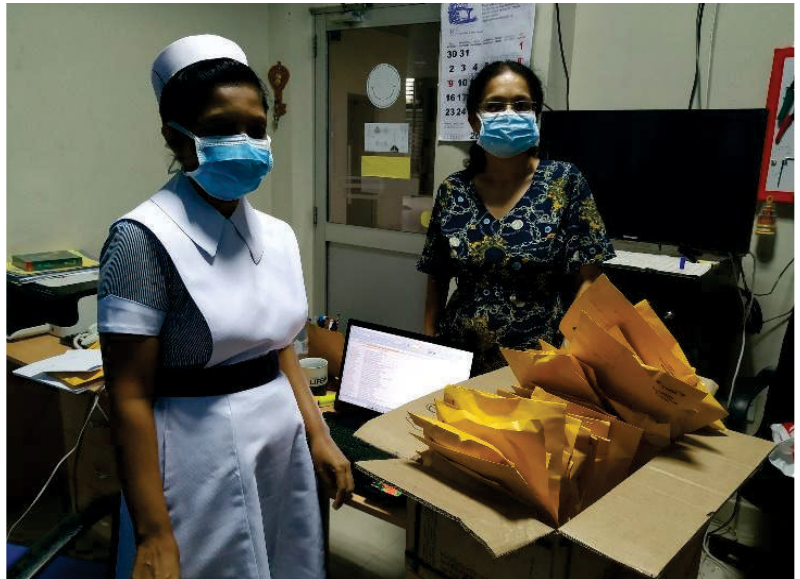
Figure 7: Packing medicines of the clinic patients for postal